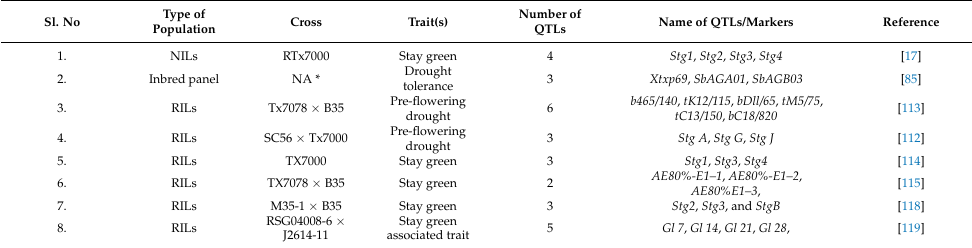
Table 3. QTLs identified for drought tolerance traits in